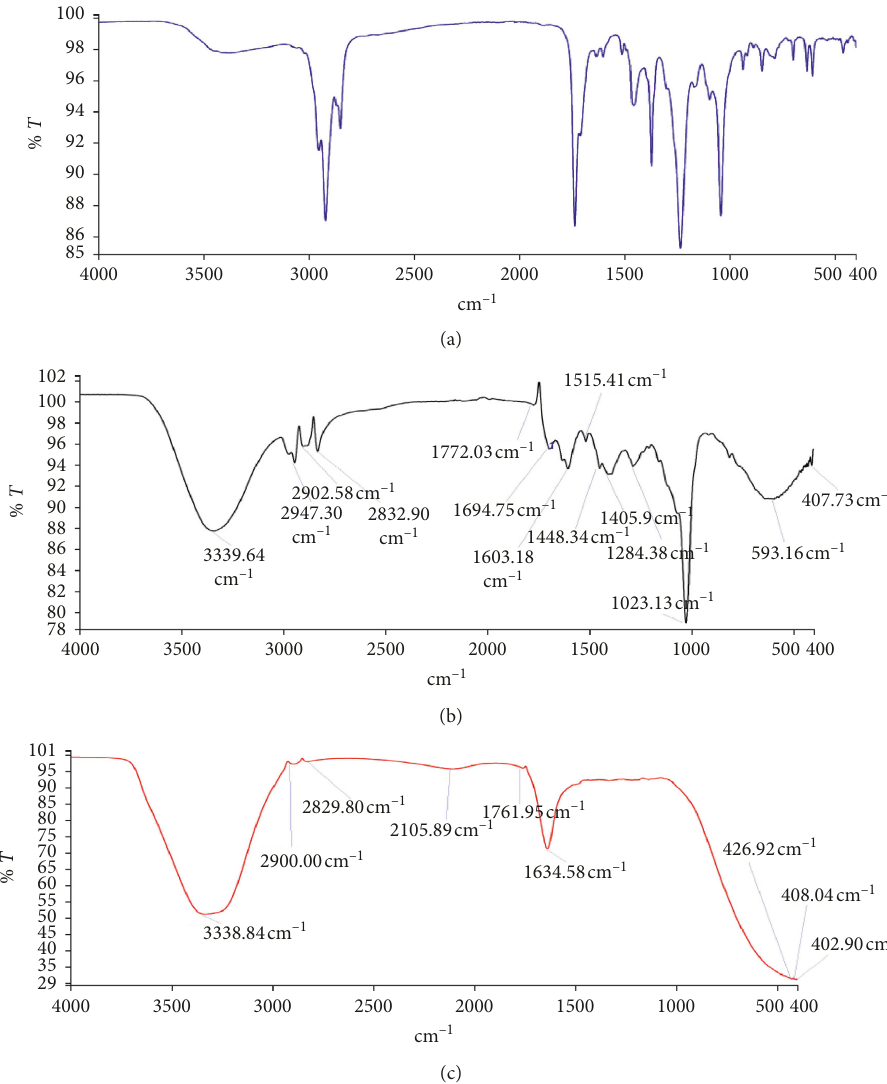
Figure 2: FTIR spectrum of ethyl acetate (a), methanolic fraction (b), and hydro fraction (c) of D. erecta unripe fruit